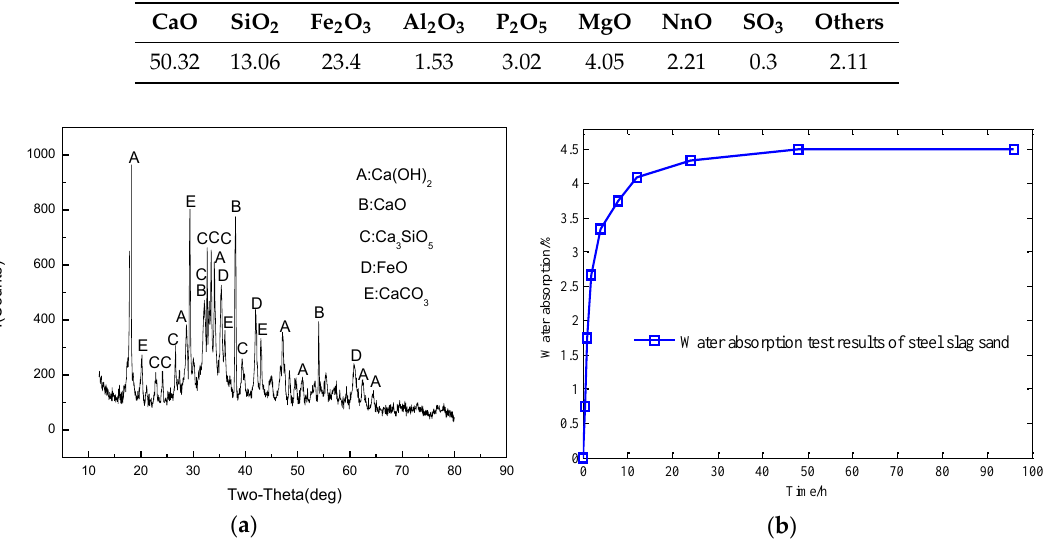
Figure 1. Grading of fine aggregates according to sieving analysis test. Table 7. Chemical compositions of steel slag.